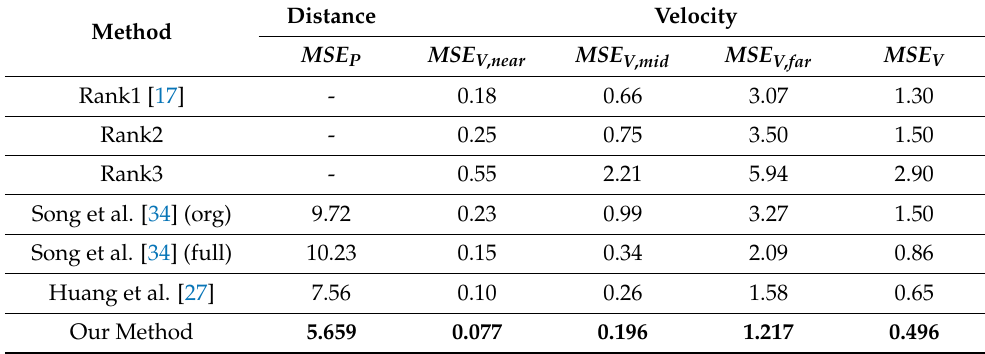
Table 3. Quantitative results of distance velocity estimation on the Tusimple dataset.